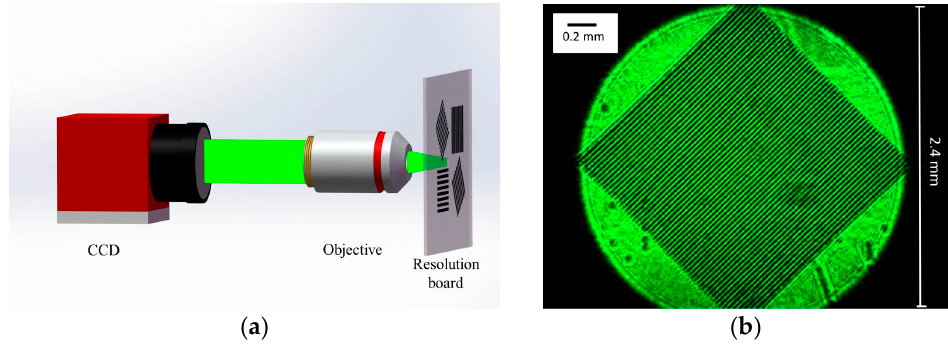
Figure 4. ( a ) Schematic diagram of imaging by CCD and objective; ( b ) the captured image corre- sponds to the yellow contour region in Figure 3c.